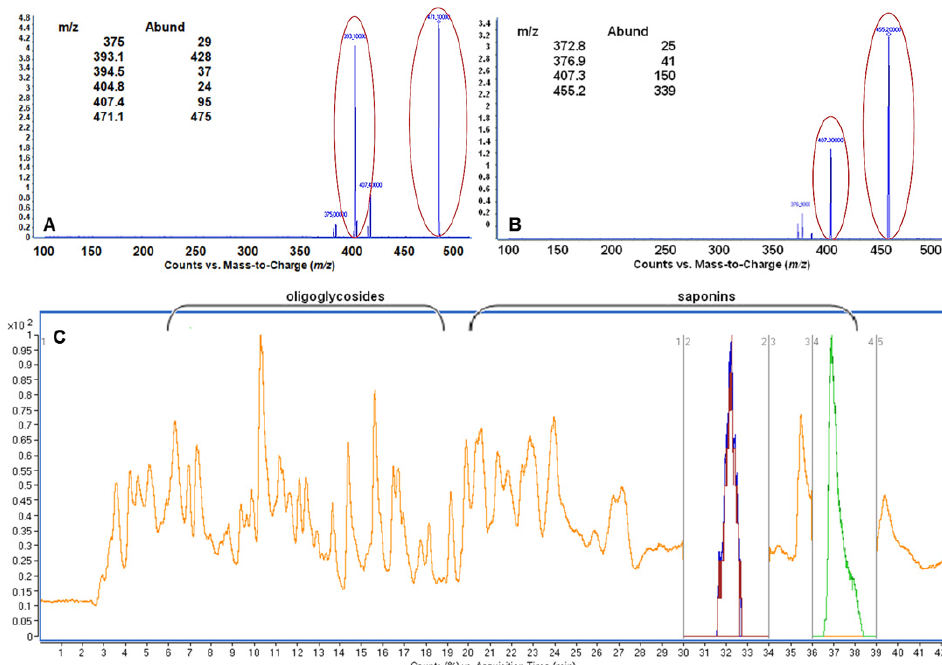
Figure 3. MS spectra of hederagenin ( A ; negative polarization, m / z 471.1), oleanolic acid ( B ; negative polarization, m / z 455.2) and example of LC/MS chromatogram of washnut extract ( C ).